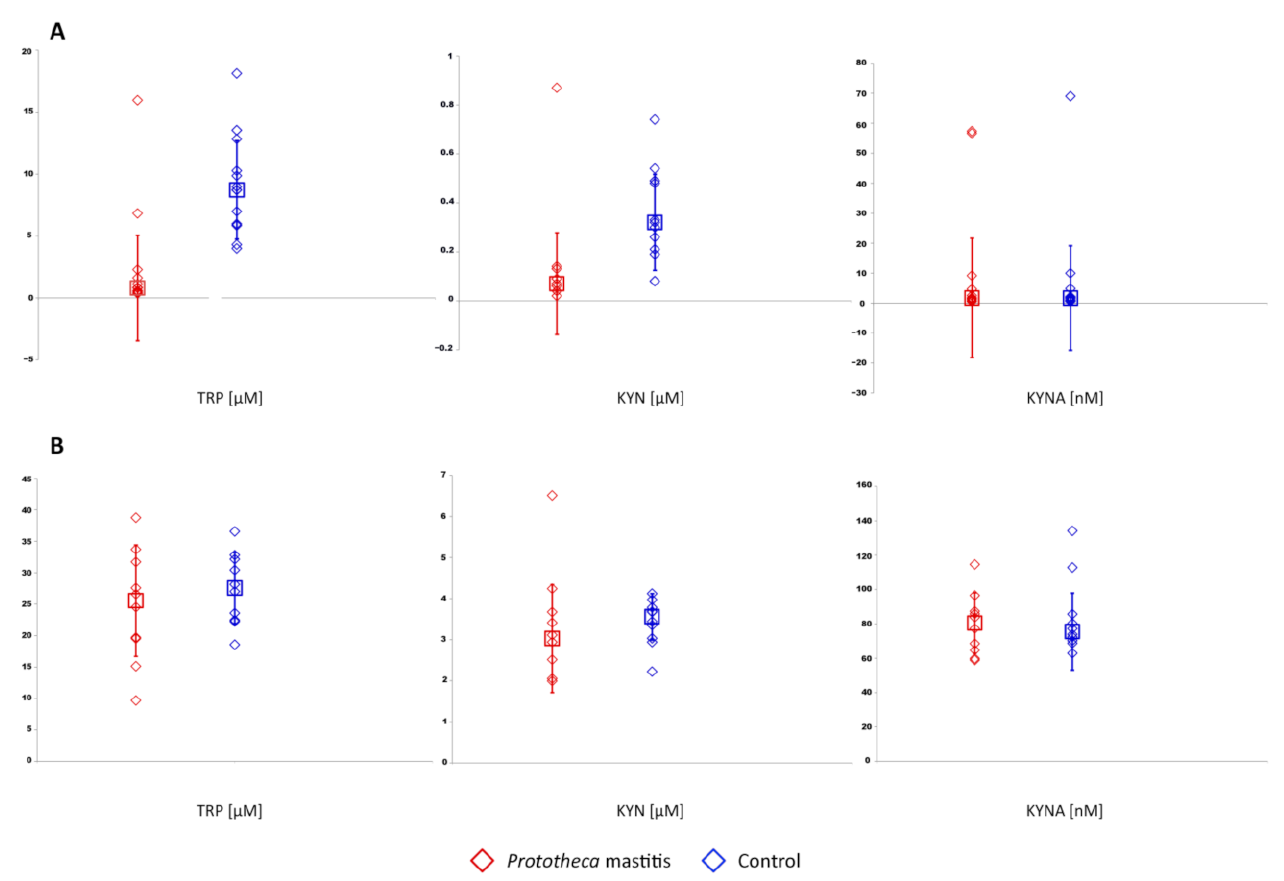
Figure 1. TRP, KYN, and KYNA concentrations in milk ( A ) and serum ( B ) of cows with Prototheca mastitis and control animals. The median and standard deviation are represented as squares and vertical lines,